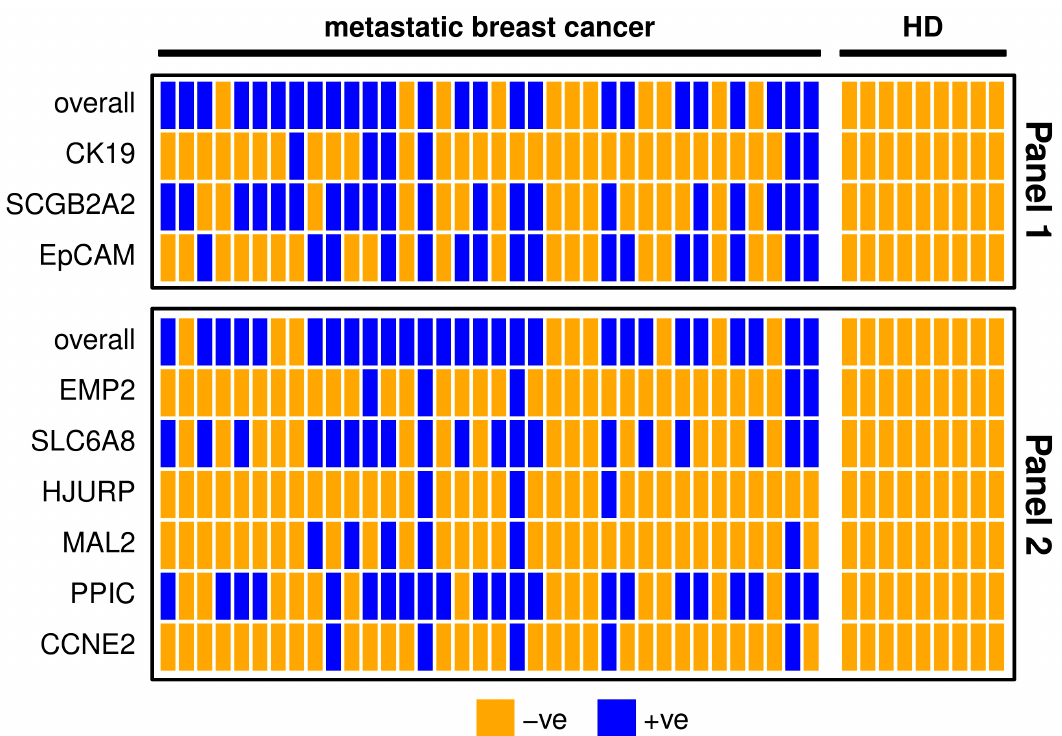
Figure 1. Heatmap showing metastatic breast cancer patient (n = 36) and healthy donor (HD, n = 9) samples for each marker separately and overall. For the definition of positivity, a threshold was set considering the gene expression levels in the HD group, in order to allow a maximum of 10% positive findings in the HD group. Samples with positive findings are marked blue and with negative findings orange. Panel 1 is shown in the upper graph and Panel 2 in the lower graph.